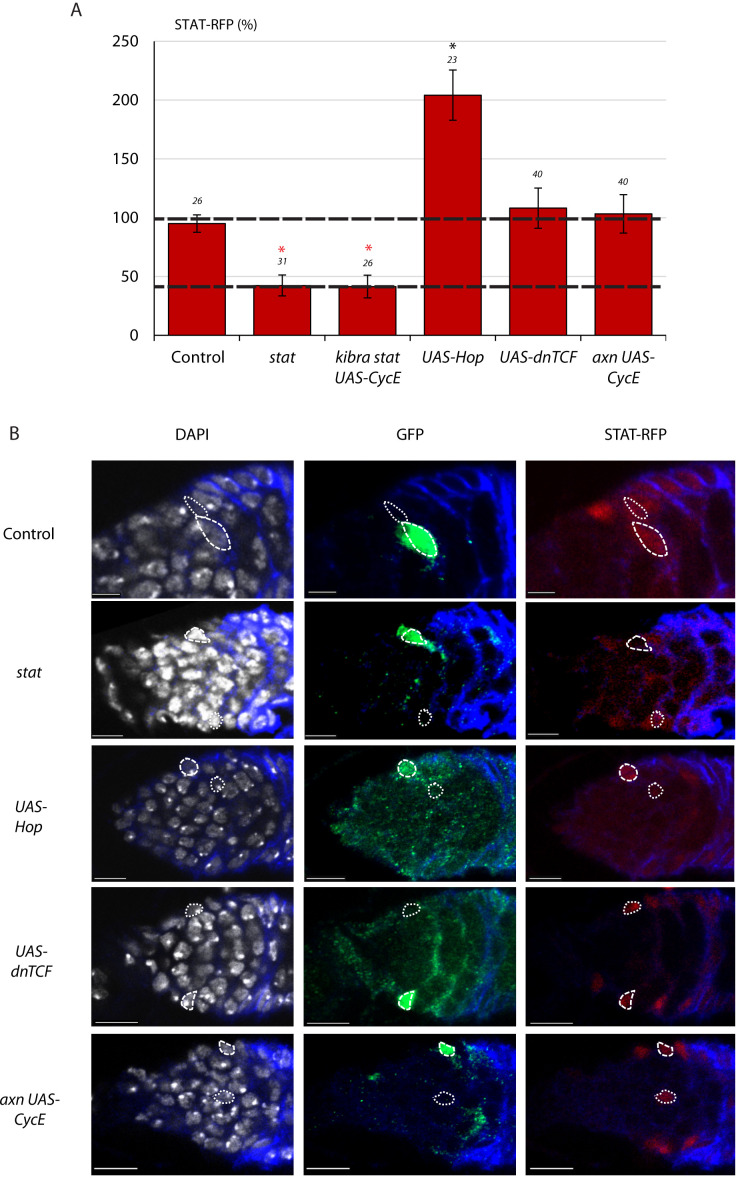
STAT-RFP intensity is not affected by Wnt pathway activity.(A) Average STAT-RFP JAK-STAT pathway reporter intensity in MARCM lineages of the indicated genotypes compared to unmarked neighbors at the same AP location and in the same z-section (set at 100% and indicated by the dashed line) with the number of cells measured above the columns. A second dashed line (at 39%) represents the RFP intensity observed in stat mutant cells, which are expected to have no JAK-STAT pathway activity (39%). (B) Images showing the outlines of GFP-positive cells (long dashed line) of the indicated genotypes and their unmarked neighbor (short dashed line) traced from DAPI nuclear staining (white) to evaluate STAT-RFP (red) intensity. Fas3 (blue) and all scale bars are 10 μm.Figure 5—figure supplement 1—source data 1.Numerical data for graphs in Figure 5—figure supplement 1.